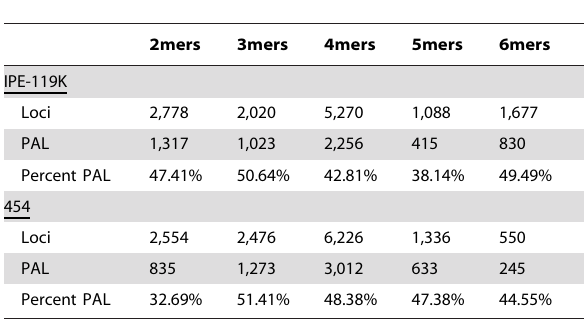
Table 2. Comparison of microsatellite and PAL identification from Illumia paired-end reads versus 454 reads for the Burmese Python, broken down by microsatellite repeat motif